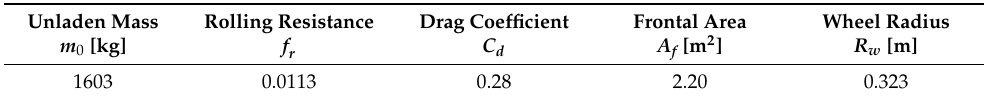
Table 4. Chevrolet Volt